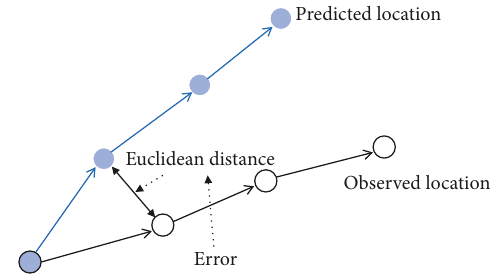
Figure5:ErrordefinedbyEuclideandistancebetweenthepredicted location and the observed